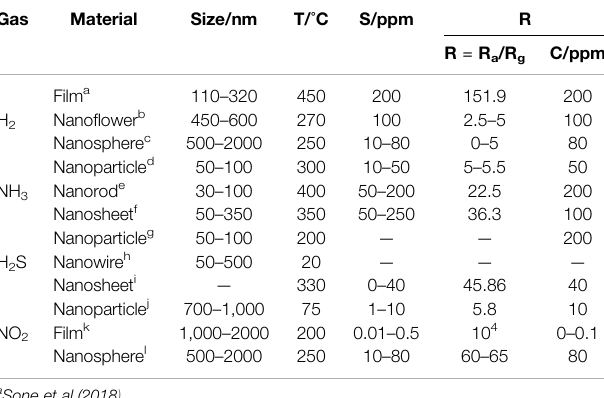
TABLE 4 | The relationship between surface oxygen vacancy and oxygen density of 2D h-WO 3 (Tian et al., 2018). 2D h-WO 3